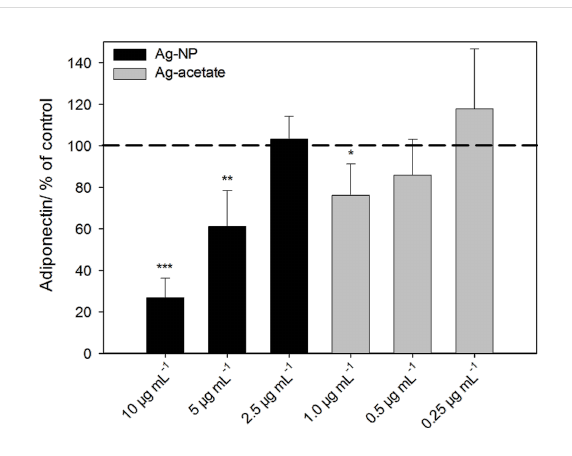
Figure 5: Release of the adipogenic differentiation marker adiponectin after hMSCs were incubated with Ag-NP/Ag + ions. After incubation with different concentrations of Ag-NP/Ag + ions for 24 h, the silver- treated cells were washed, and particle-free medium (adipogenic-dif- ferentiation medium) was added. After 14 d of incubation, the amount of released adiponectin was measured. The data are expressed as the mean ± SD ( n = 7 independent experiments), given as the percentage of the control (Adiponectin 191 ± 13 ng·mL − 1 ; cells cultured without silver, dashed line). The asterisks (*) indicate significant differences with respect to the control (* p < 0.05, ** p < 0.01, *** p < 0.001).